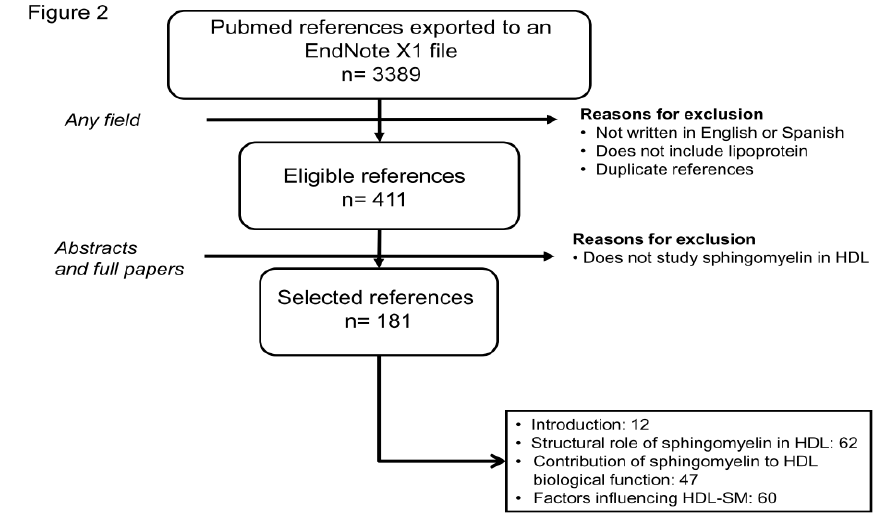
Figure 2. Flow chart displaying the stages used to select the references considered. The present report has adhered to systematic review guidelines [14]. A search in Pubmed (http://www.ncbi.nlm.nih.gov/pubmed/) using the keywords “high-density lipoprotein and sphingomyelin,” “sphingomyelin and diet,” “sphingomyelin and drugs,” “plasma and sphingomyelin,” identified 3,389 hits from November 1945 to March 2013. Documents that failed to meet the criteria shown were discarded. Thus, this review covers the works related to sphingomyelin and HDL in 181 papers. EndNote X1 (Bld 2566, Thomson Reuters: New York, NY, USA,